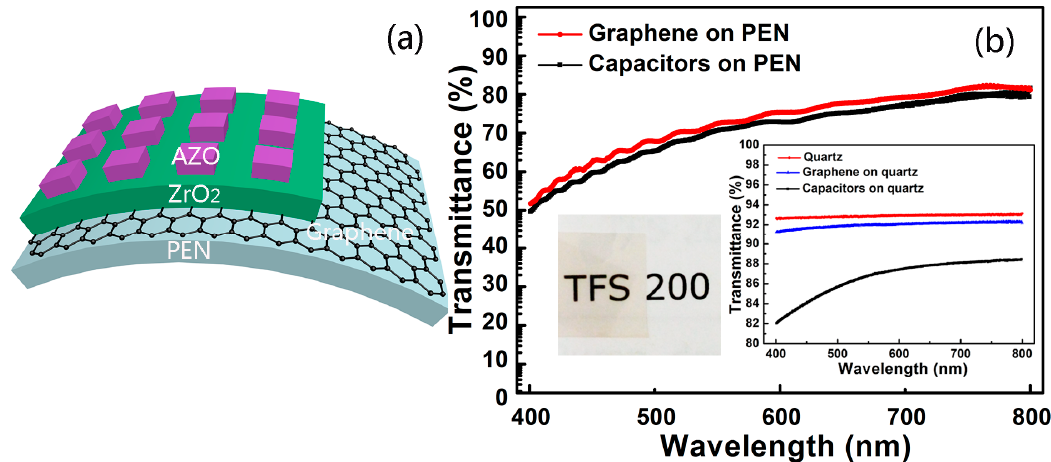
Figure 4. ( a ) The schematic diagram of the ultrathin, transparent and flexible capacitors; ( b ) The optical transmittance spectra of the capacitors on PEN substrates. The inset shows the optical photograph of the actual capacitor device with the characters “TFS 200” in the background, and the optical transmittance spectra of graphene and capacitors on quartz substrates.